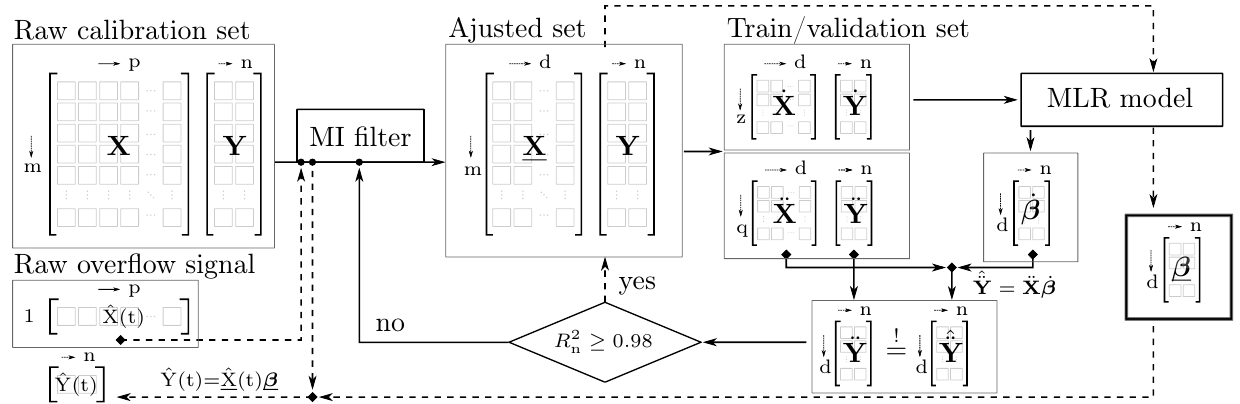
Figure 5. Graphical representation of the sensor software setup described in Sections 3.2.1 and 3.2.2. Matrices are denoted as brackets with their dimensions drawn on the top and left. The inner loop (solid arrows) highlights the calibration procedure including supervised feature selection with an MI filter, model training and diagnostic measures. The outer loop (dashed arrows) visualizes the translation of raw UV/vis process data ˆY(t) into a prediction of the suspension composition